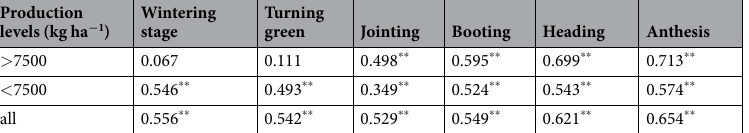
Table 1. Pearson’s correlation between grain number per spike and aboveground dry matter at different stages. Notes: n = 228; * Significant at the 0.05 probability level; ** Significant at the 0.01 probability level.